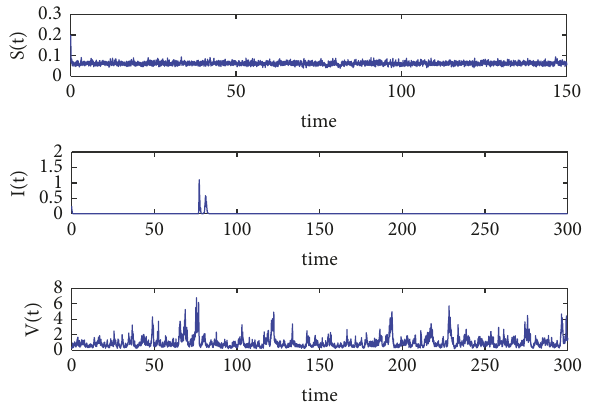
Figure 3: Simulation of the paths 𝑆(𝑡),𝐼(𝑡) , and 𝑉(𝑡) for model (3).